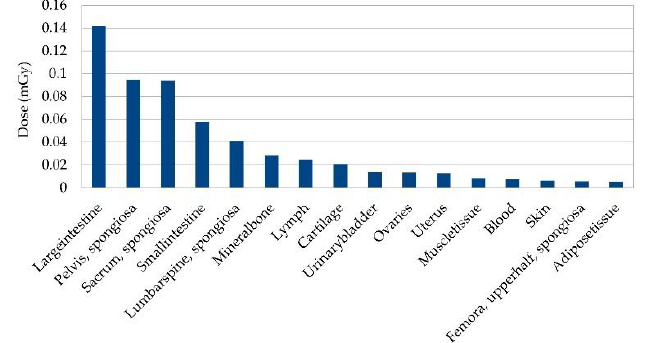
Figure 9. Organ dose deposition for 16 tissues with highest dose for scan of a slice in abdomen. This is estimated for a total of 120 scanning positions (24 simulated positions times 5), only located at a certain region of interest. It is thus to be understood as best case scenario, where almost no irrelevant positions were scanned.